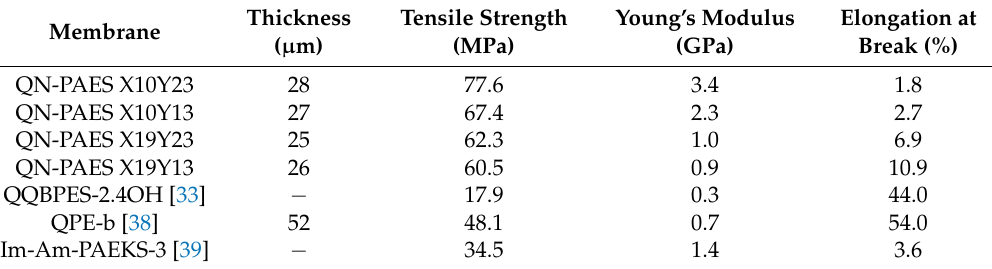
Table 3. Thickness and mechanical behaviors of membranes.